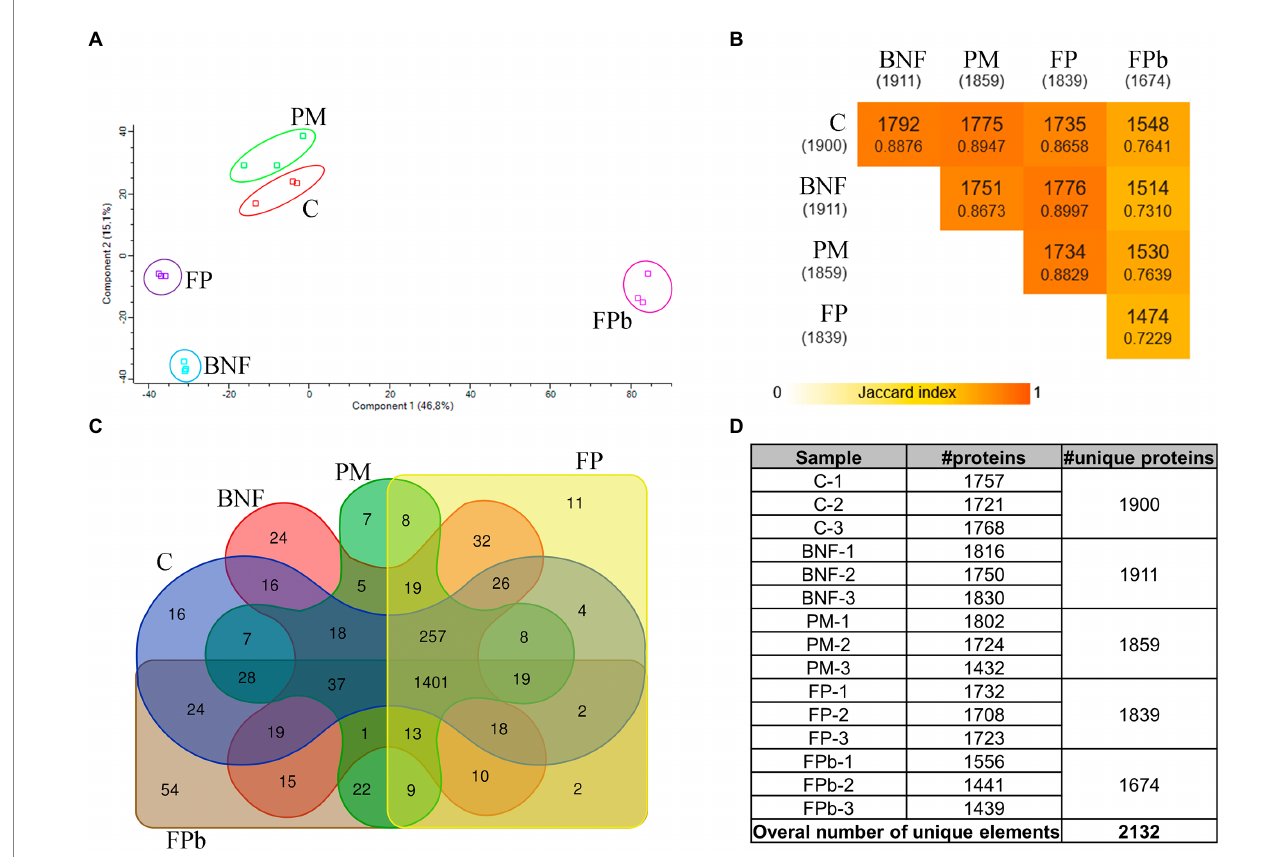
FIGURE 2 Exploratory proteome analysis. (A) Principal component analysis, (B) Jaccard index, (C) Venn diagram, (D) Summary table of the number of proteins identified per replicate, condition and in total. C, control condition; BNF, biological nitrogen fixation condition; PM, phosphorus mobilization condition; FP, biological nitrogen condition and phosphorous condition (21 h); FPb, biological nitrogen condition and phosphorous condition (72